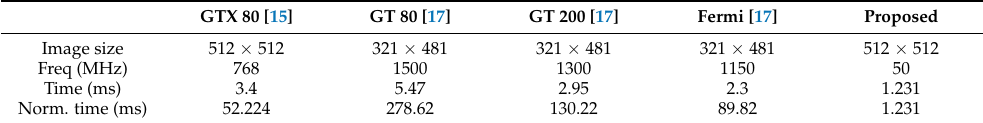
Table 3. Run time comparison of GPGPU and proposed FPGA implementation. GTX 80 [15] GT 80 [17] GT 200 [17] Fermi